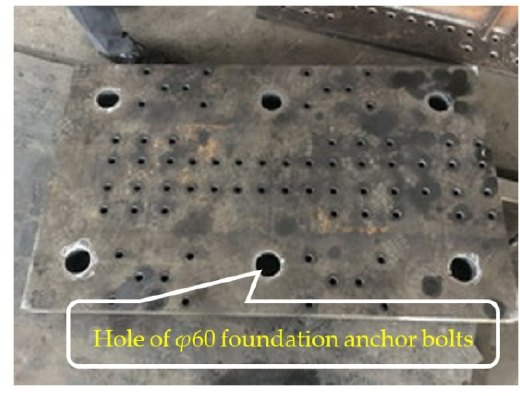
Figure 9. 60 mm thick connecting plate.